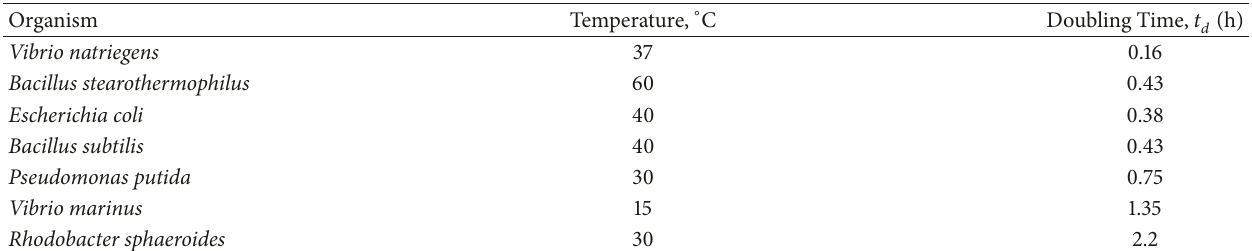
Table 4: Maximum recorded growth rates for some organisms measured near their respective optimal temperature in complex media